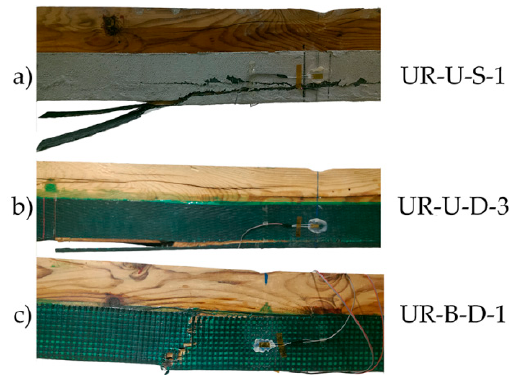
Figure 15. Breakage patterns of the UR beams group: ( a ) UR-U-S-1; ( b ) UR-U-D-3; and ( c ) UR-B-D-1. CFRP suppliers: SIKA ® and DRIZORO ® .